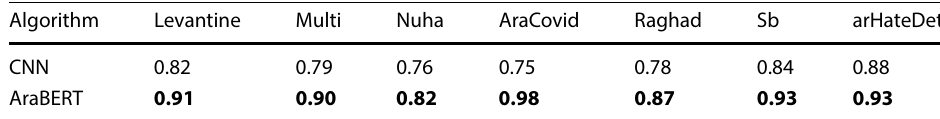
The bold values represent the highest